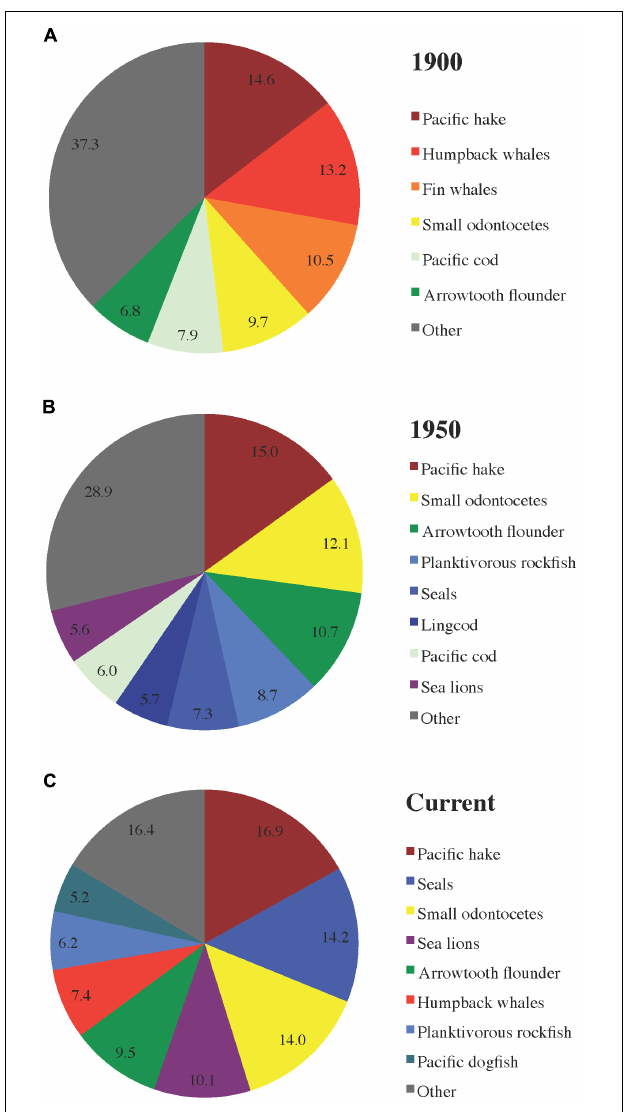
FIGURE 4 | Proportions of total predator consumption of herring (all stocks and age/size classes combined) attributable to major predator functional groups in the (A) 1900, (B) 1950, and (C) current ecosystem